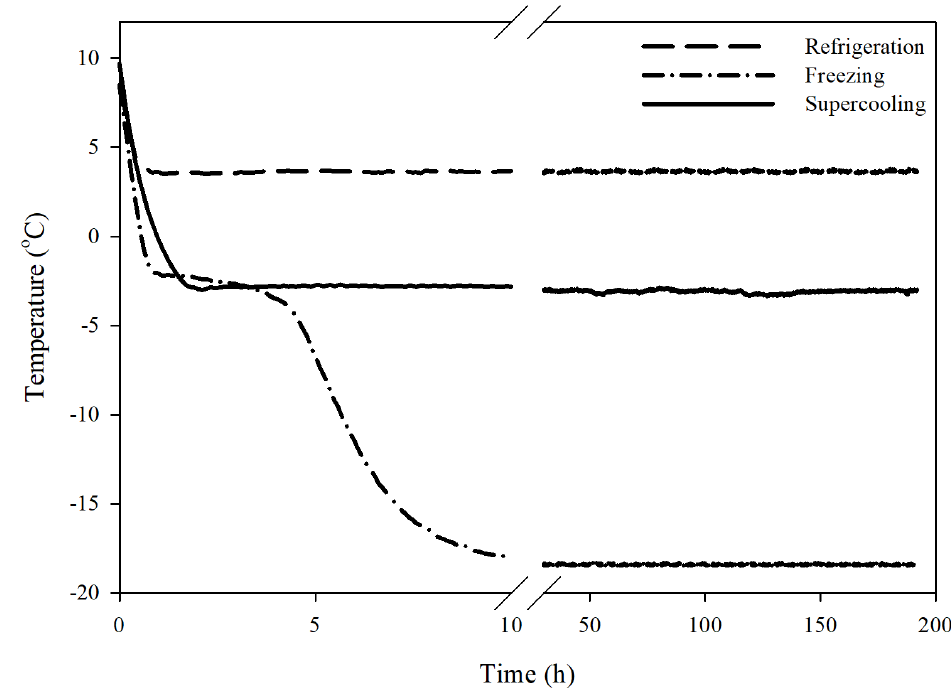
Figure 2. Representative temperature profile of the supercooled tuna (80 g) in comparison with a refrigerated (4 °C) and frozen (−8 °C) control sample. Note that freezing did not occur in the supercooled sample by the combined PEF and OMF treatment for 8 days at the temperature of −3.2 °C.